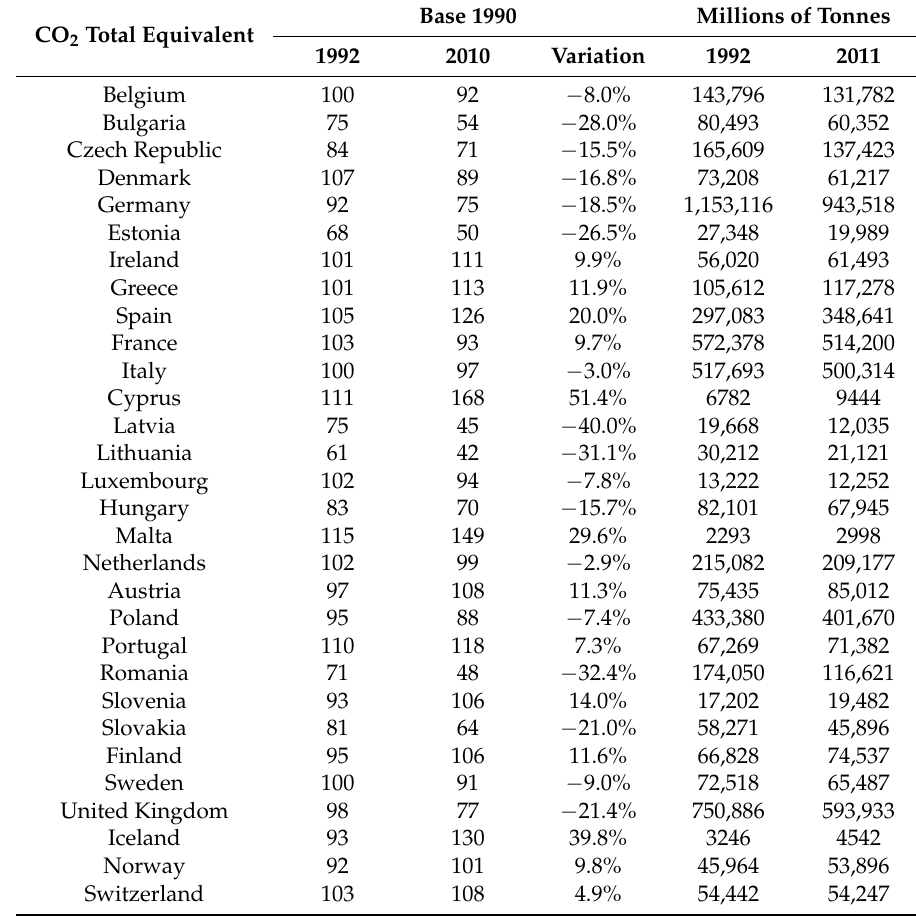
Table 1. Descriptive. Dependent variables.